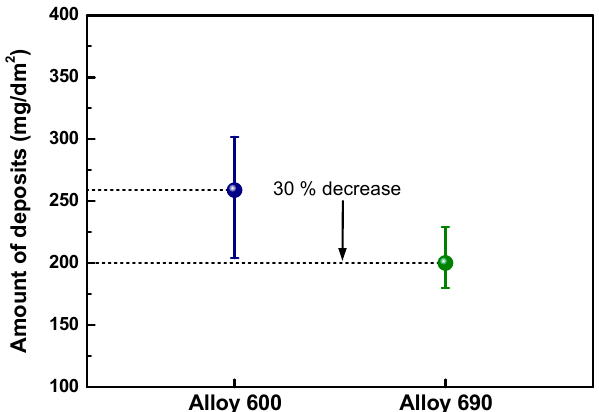
Figure 12. Amount of magnetite deposits on SG tubes using ICP ‐ OES analysis.